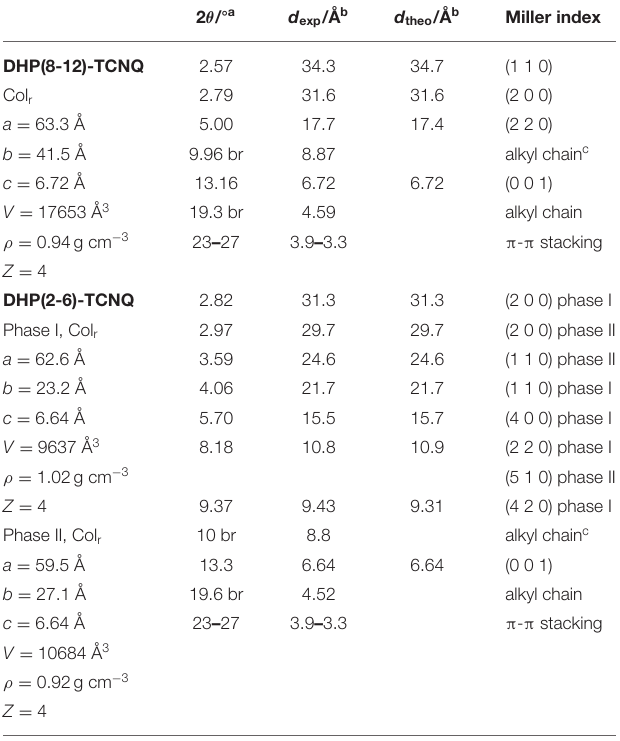
Changes in the Macroscopic Orientation by Rubbing Treatment Figure 6 shows polarized UV-Vis-NIR spectra of a unidirectionally rubbed film of DHP(8-12)-TCNQ prepared on a quartz substrate, with varying the angle between the polarizer axis (P) and rubbing direction (R). Both the ICT absorption (at 1422 nm) and the intramolecular electronic transition bands (at 360, 430, and 600 nm) can be seen. Interestingly, these spectral intensities reached a maximum when P ⊥ R ( Figure 6 inset). Therefore, the transition dipole moment for CT absorption [parallel to the column axis ( c -axis)] and that for intramolecular absorptions [parallel to the long axis of TCNQ (mainly b -axis)] should be oriented perpendicular to R. In other words, the uniaxial orientation of a -axis is induced along with R ( Supplementary Figure 5 ). This rubbing-induced change in molecular alignment is distinct from those observed for round-discoidal columnar liquid crystals (Yoshio et al., 2004; Yasuda et al., 2006), and is rather similar to the behavior of rod-like liquid crystals. The unique structural transformation characteristics would be due primarily to the oval-like molecular structure of DHP derivatives and ICT interactions in the supramolecular copolymers. The shear-force-responsive structural transformation characteristics are also confirmed by changes in the XRD patterns of randomly rubbed films. As shown in Figure 7A , (110) and (200) reflections of Col r phase were fused to a single peak (2 θ = 2.79 ◦ ), and the other peak appeared at 5.58 ◦ after the rubbing treatment in DHP(8-12)-TCNQ . Since the experimental diffraction spacing ( d exp ) of these peaks are 31.6 and 15.8 Å, respectively, Miller indices of (100) and (200) were reasonably assigned to these peaks ( Table 2 ),